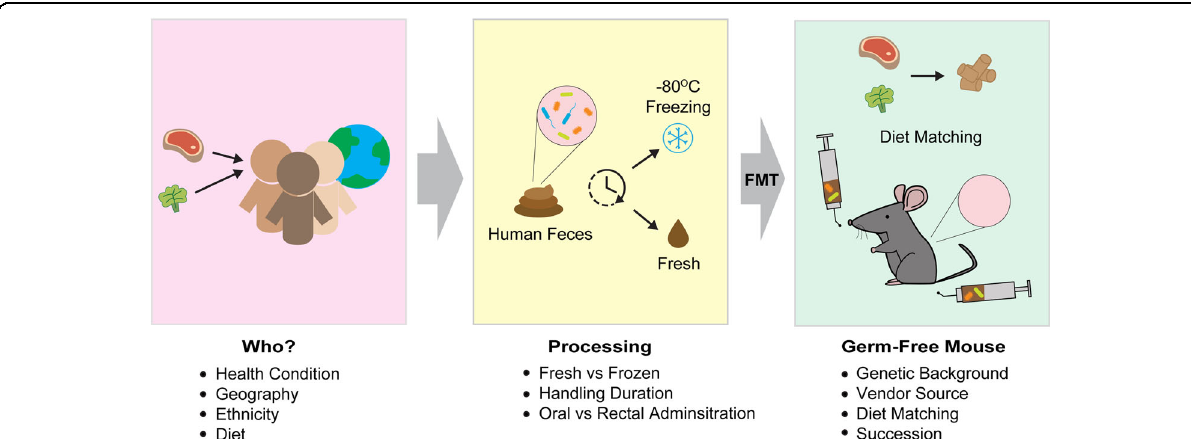
Fig. 1 Schematic diagram of creating a humanized gnotobiotic mouse model. In creating a relevant, effective, and reproducible humanized gnotobiotic mouse model, several key factors must be taken into consideration, including form whom the donor fecal samples are collected from, how the samples are processed, and which mouse is selected as the recipient. Optimization for matching the mouse feed to the donor ’ s diet will also be necessary to ensure ef fi cient continuation of the donor ’ s microbiota within the mouse